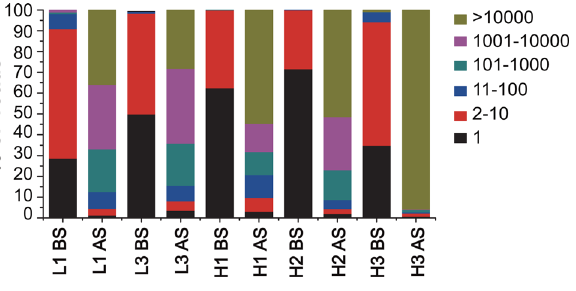
Fig 5. Frequency distribution of CDR sequences. Data analysis was performed for five individual CDRs from 13.9 and 4.5 million qualified sequences in the unselected (BS) and selected (AS) libraries, respectively. Total counts of all variants representing that particular frequency group were calculated.